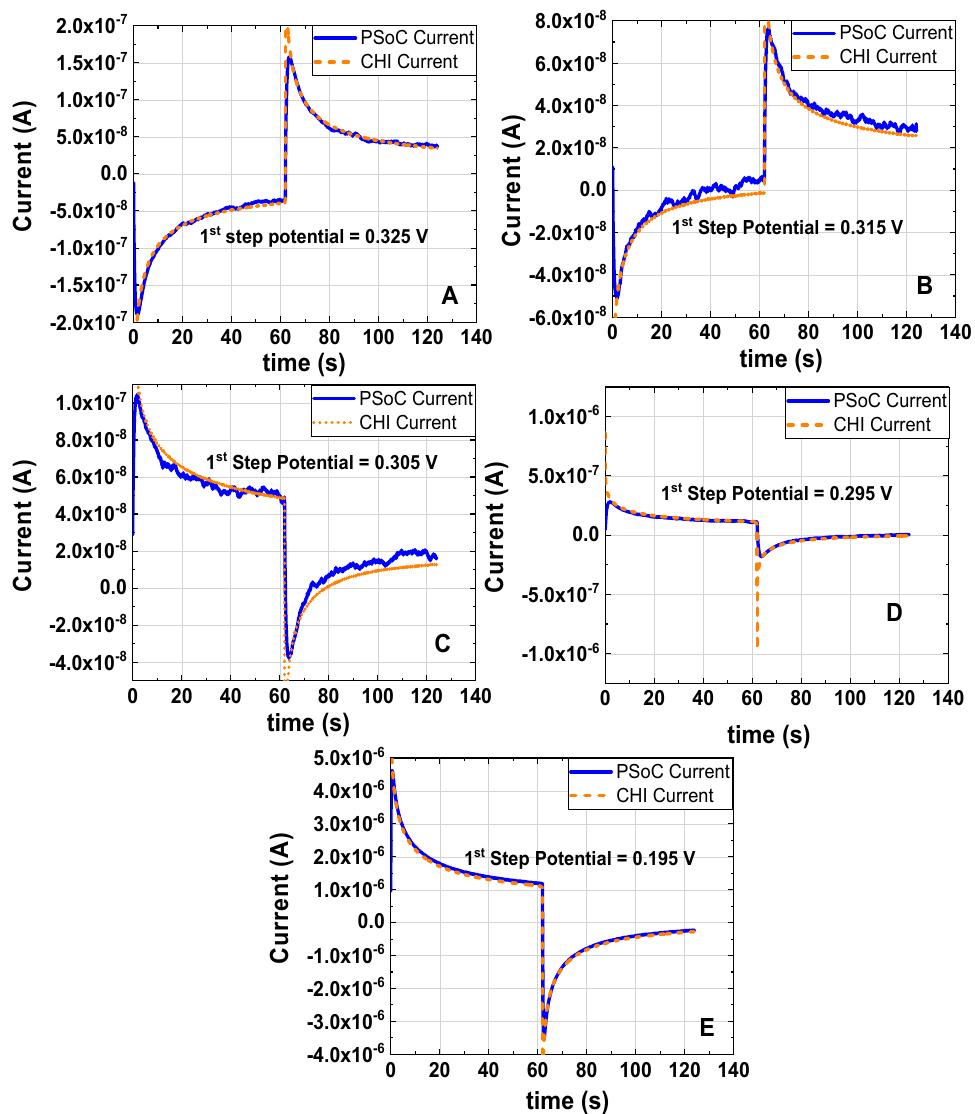
Figure 7. Double Step Chronoamperometry at different first step potentials of 1 mM K 3 [Fe(CN) 6 ] and 0.5 M KCl as the electrolyte support; the working electrode, the counter electrode and the reference electrode were a disk glassy carbon electrode (diameter φ = 3 mm), a platinum wire and Ag/AgCl electrode, respectively. All DSC were done with a pulse width of 62 s and the last step was setup at 0.310 V vs. Ag/AgCl: ( A ) first step potential 0.325 V vs. Ag/AgCl (experiment under the conditions